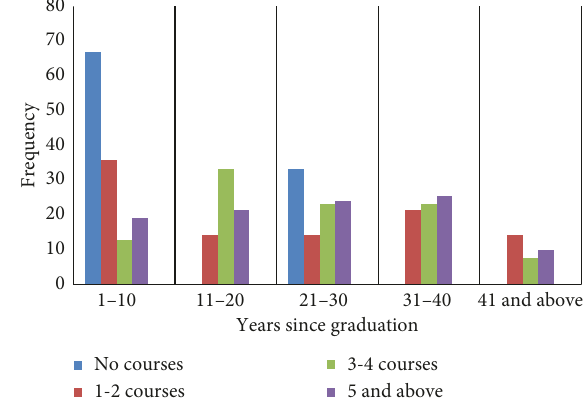
Figure 1: Association between the years since graduation and number of CPD courses